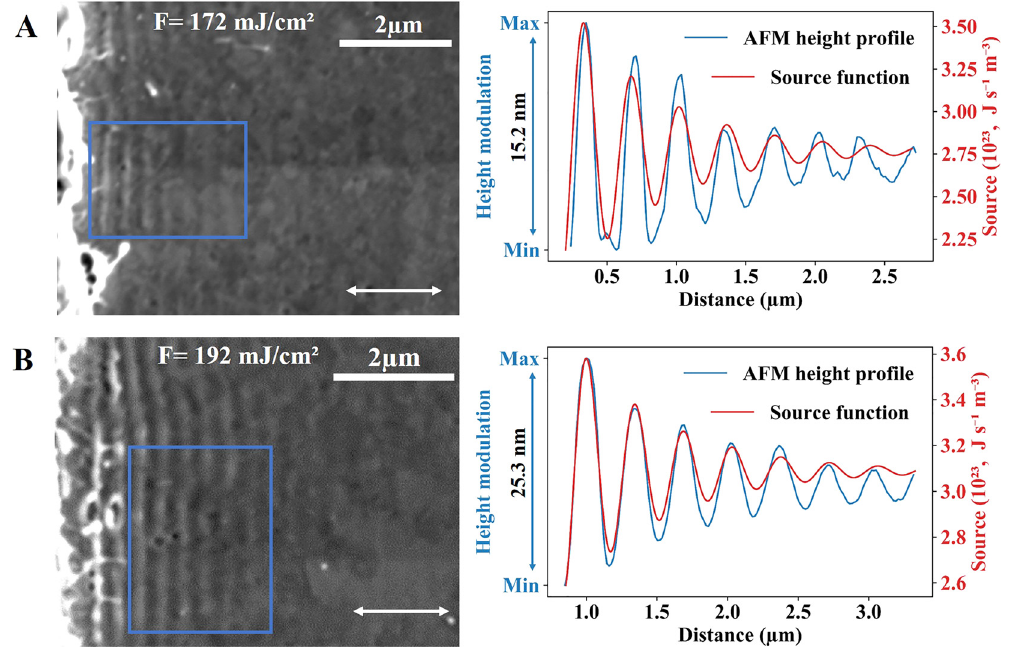
Figure 3: SEM and AFM images of LIPSS with a step edge located at the very left side of each image. SEM picture of LIPSS at the edge of the trench irradiated with the fluences (A) F = (172 ± 9) mJ/cm 2 and (B) F = (192 ± 10) mJ/cm 2 . The height pro fi le of LIPSS is measured by AFM averaged over the sections indicated in the SEM pictures. The theoretical curves of the source function are also included in the fi gure. The white horizontal double-arrows show the direction of the laser